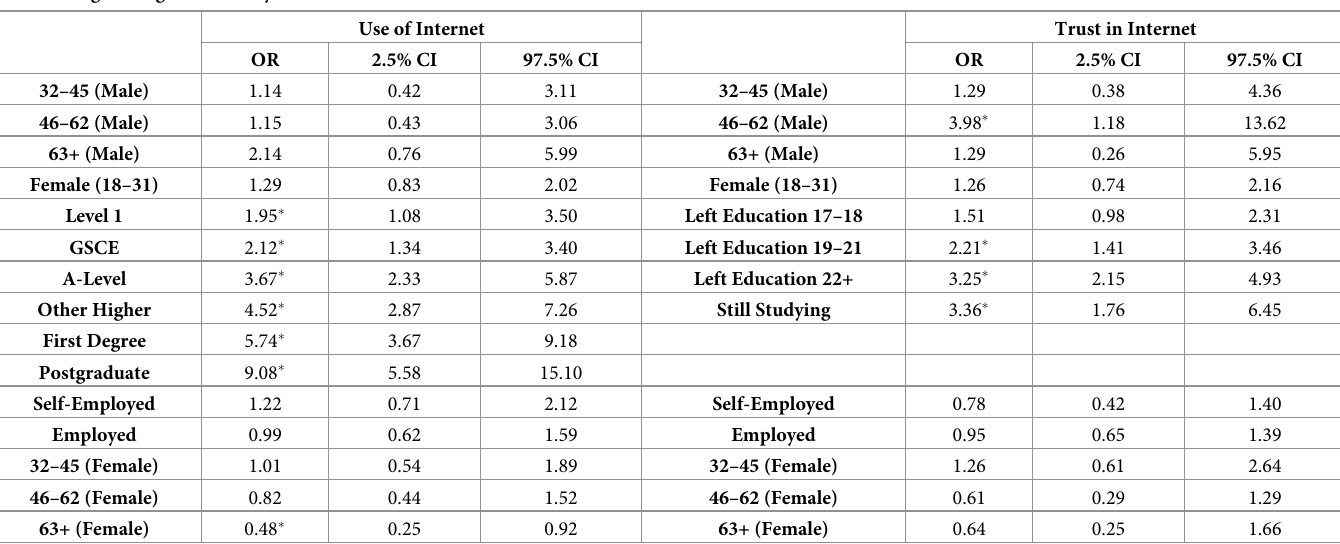
Table 2. Logistic regression analysis of internet